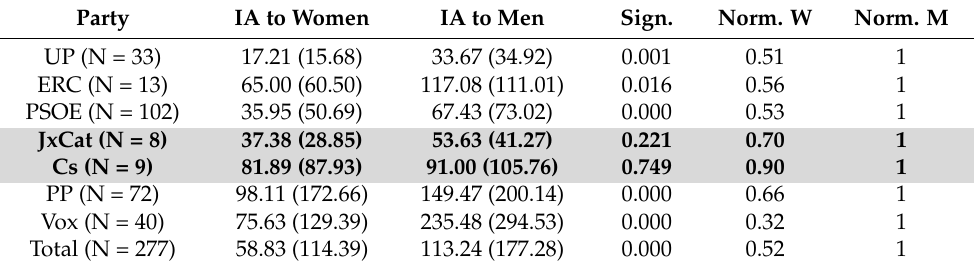
Table 7. Internal amplification (IA) among Spanish Members by